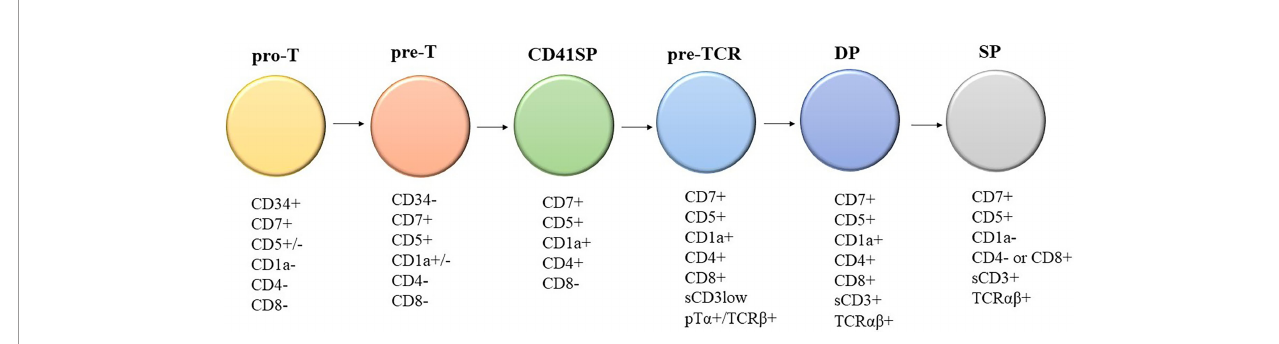
FIGURE 1 | Different stages of T-cell development and their corresponding immunophenotypes: Pro-T, pre-T, immature CD4 single positive (CD4ISP), pre-T-cell receptor (pre-TCR), CD4 and CD8 double positive (DP), and single positive (SP). sCD3: surface CD3; pT a +/TCR b +: Pre-T-cell receptor alpha and TCR beta chain.